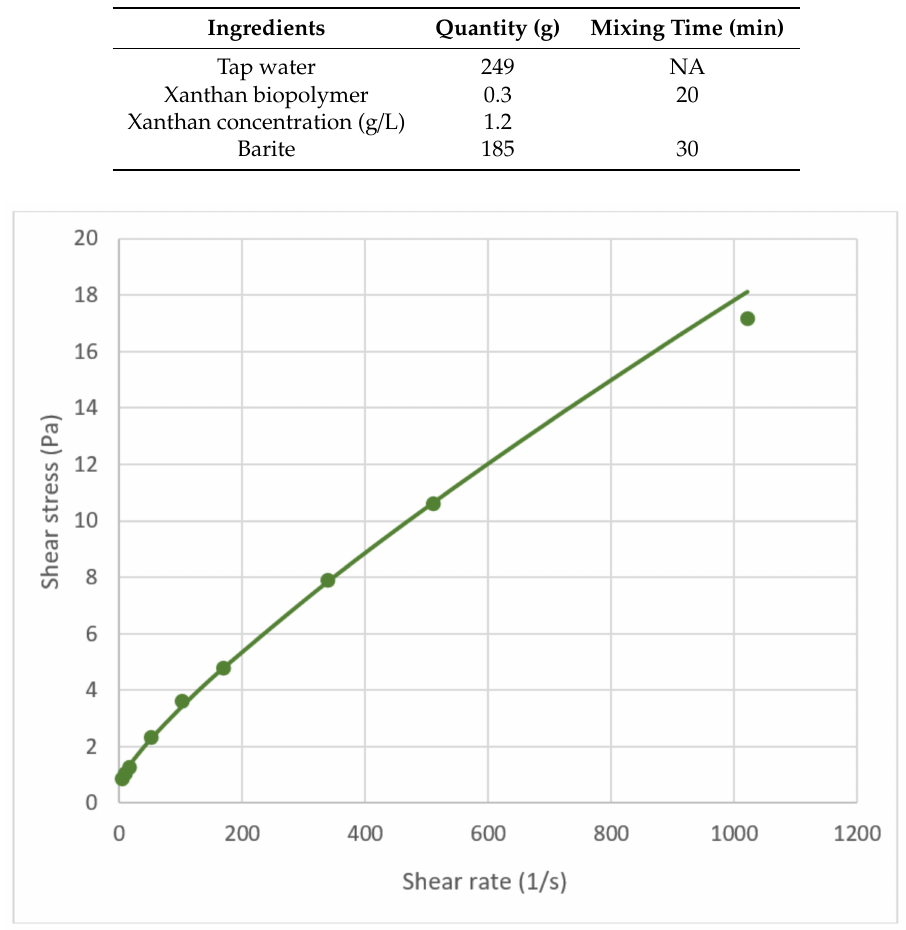
Table 1. Mix design and mixing procedure for the model drilling fluid.